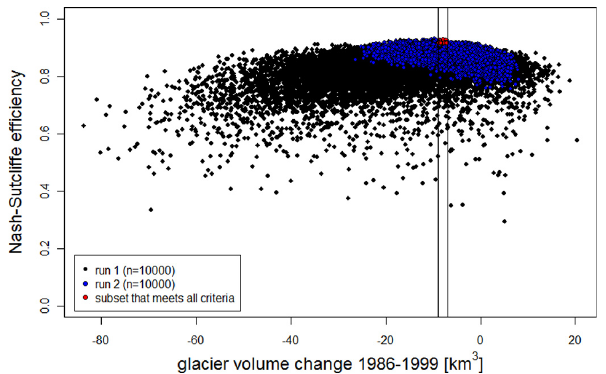
Fig. 3. Nash-Sutcliffe efficiency ( E ) plotted against simulated glacier volume change for 10000 model runs in the initial Latin Hypercube Search (black) and for 10000 model runs in a Latin Hy- percube Search with adjusted prior parameter distributions (blue). Red dots indicate acceptable parameter combinations.